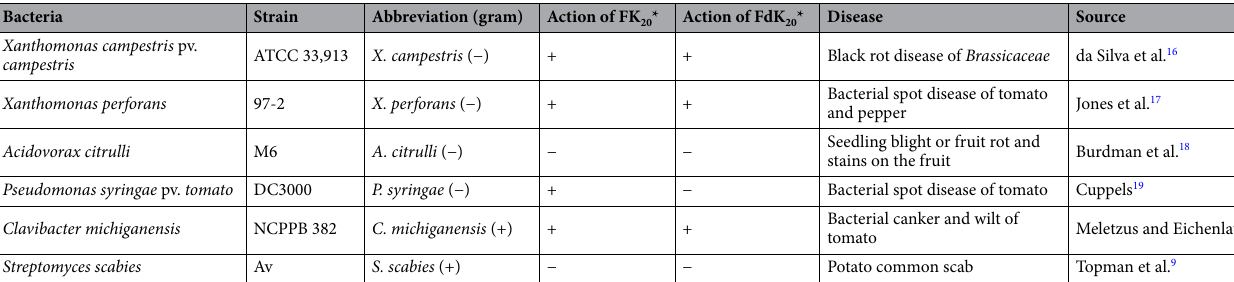
Table 1. Strains, abbreviations, agricultural threat of the plant-pathogenic bacteria used in this study and action of two random peptide mixtures. *(+) Effect, (−) no effect of the random peptide mixtures on the bacterial